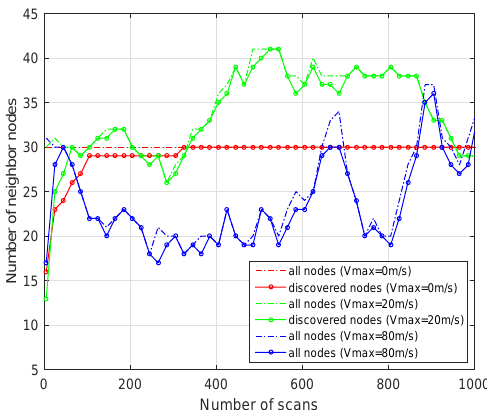
Figure 16. The number of discovered nodes for one single node with different moving